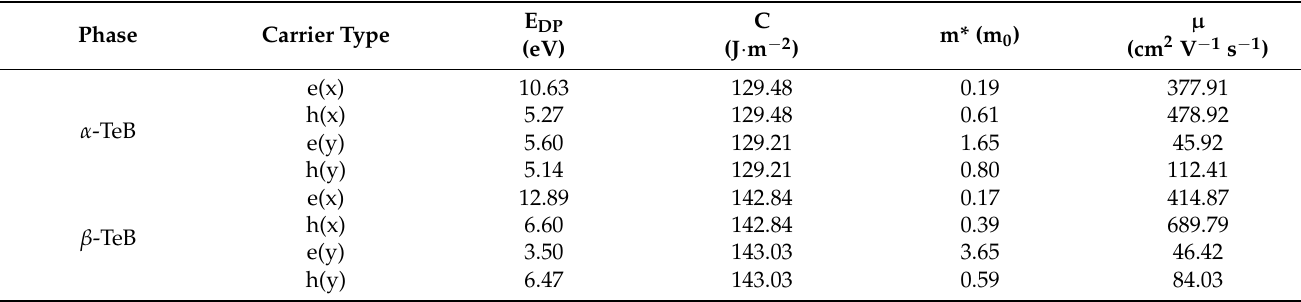
Table 3. Calculated deformation potential constant (EDP), 2D in-plane stiffness (C), effective mass (m*), and carrier mobility ( µ ) along the x and y directions for α -TeB and β -TeB monolayers at 300 K, respectively. Phase